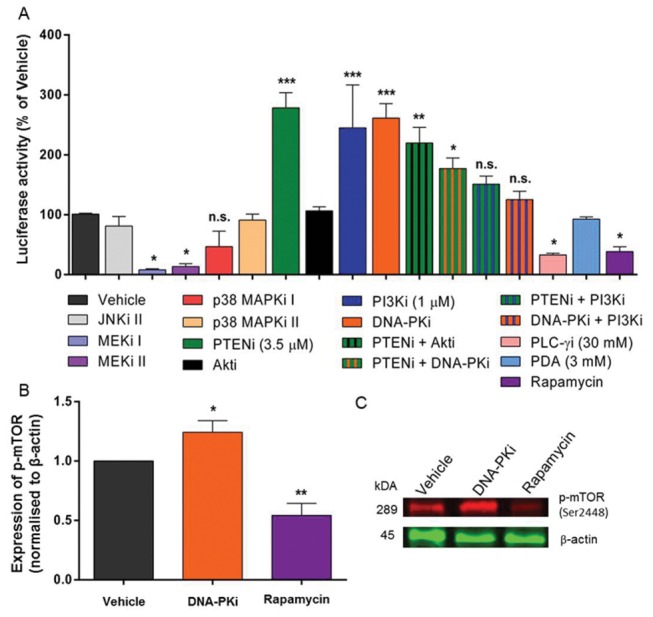
Activation of PI3K and PIKK signaling pathways induces Lmx1a reporter gene expression.Panel A shows the luciferase activity from Lmx1a-luc mESCs on day 8, after incubation with combinations of SMAs from day 4-8. PD169316 and SB220025 are inhibitors of p38 MAPK pathway whereas U-73122 specifically inhibits PLC-γ signaling. Solid colored columns represent incubations with single SMAs whereas striped columns depict combination incubation of SMAs. Western Blot analysis (B and C) revealed that DNA-PKi induces phosphorylation of mTOR, another member of the PIKK superfamily, whilst Rapamycin inhibited its phosphorylation. Membranes were probed for mTOR specifically phosphorylated at Serine 2448 (Ser2448) and β-actin using primary antibodies. Proteins were visualized using donkey anti-rabbit AlexaFluor 680 and donkey anti-mouse IE-800 for mTOR and β-actin, respectively. Data presented as mean ± SEM, ***p<0.001, **p<0.01 and *p<0.05 for one-way ANOVA compared to vehicle using Bonferroni’s post-hoc test, n=3. Abbreviations: PTENi- Phosphatase tensin homologue inhibitor, JNK- Janus Kinase, MEK- Mitogen-activated protein kinase kinase, PDA- Phorbol di-acetate and mTOR- Mammalian target of rapamycin.